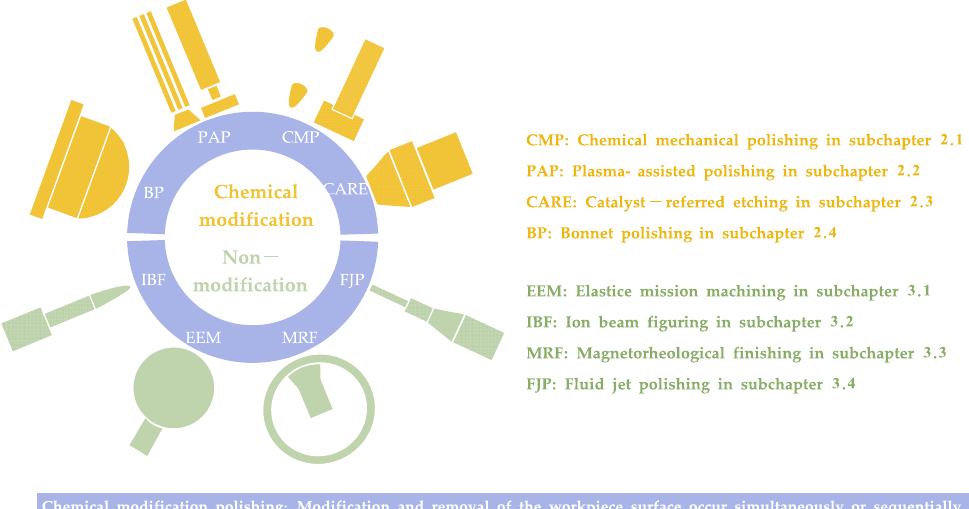
Figure 2. The demands and polishing approaches at ACS: ( a ) Measurement apparatus of the ring laser gyroscopes [40]; ( b ) Schematic drawing of focusing by a deep ultraviolet [41]; ( c ) Schematic of the tabletop extreme ultraviolet microscope [42]; ( d ) Schematic representation of an X-ray micro- probe. Reproduced with permission from [43].